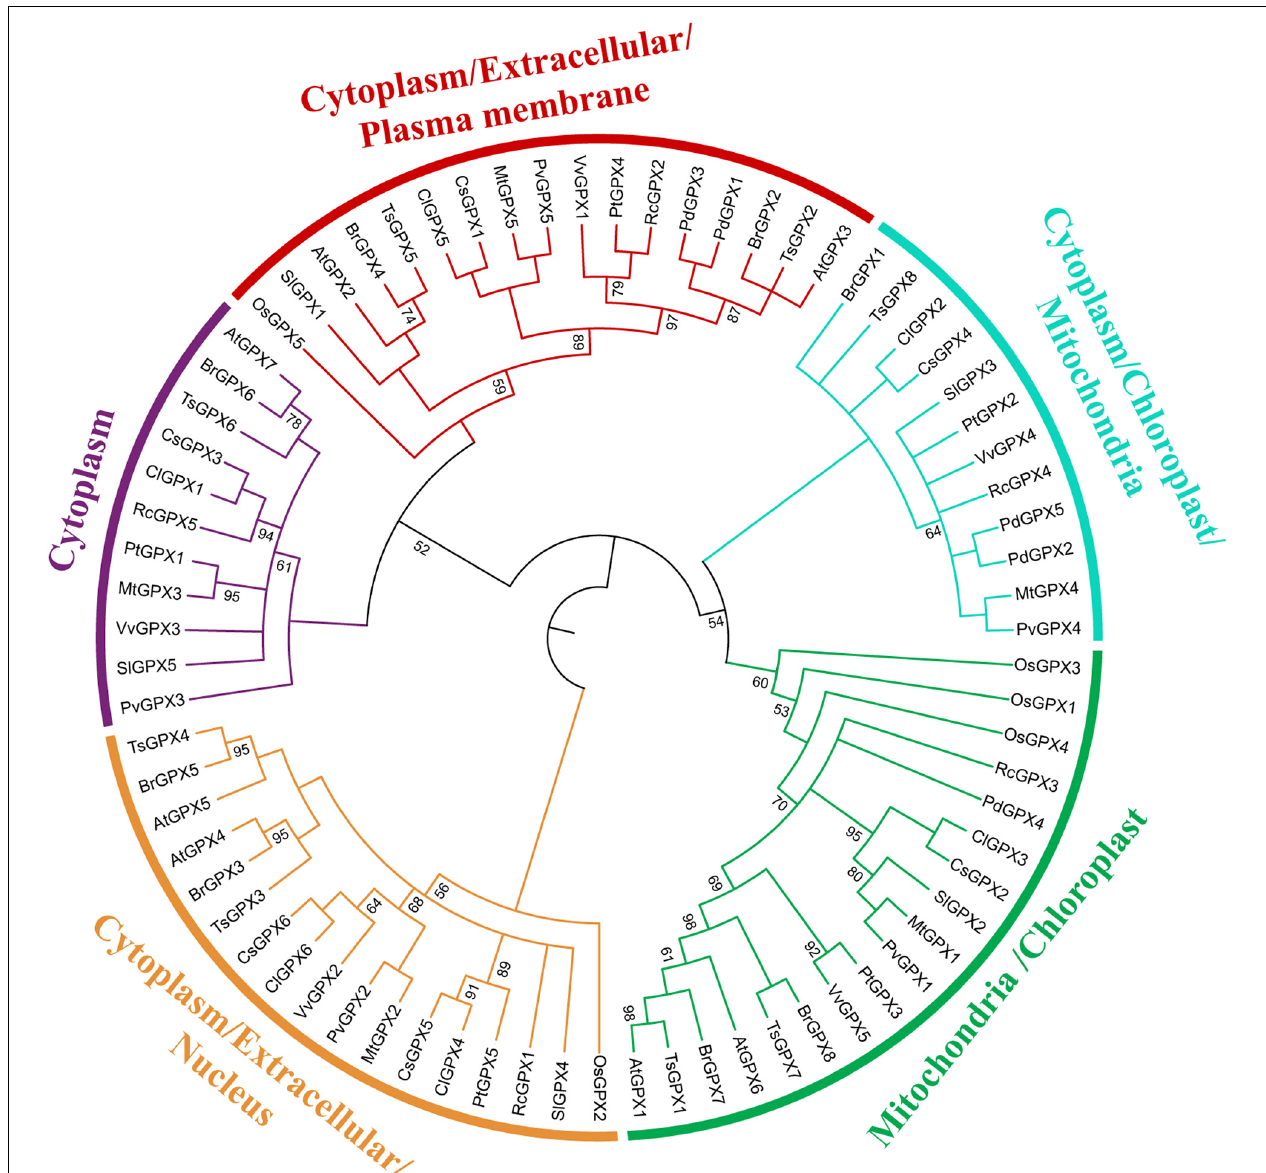
FIGURE 3 | Phylogenetic tree of 75 GPX protein sequences based on 166 positions. The numbers at some branches indicated the posterior probability (posterior probability > 99 was not displayed). The tree topology as shown here was identical in the Bayesian inference (BI) analyses. The different colors of each branch indicated the different groups. GPXs, glutathione